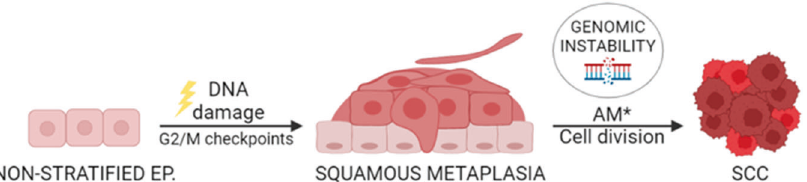
Fig. 7 Model for the role of DNA-damage and mitotic checkpoints in the development of squamous metaplasia and subsequent squamous cancer in non-strati fi ed epithelia. Chronic or acute exposure of non-squamous epithelia to genotoxic agents would drive G2/M arrest via the DNA damage response. In turn, G2/M checkpoints would drive benign hyperplastic squamous differentiation (squamous metaplasia). Unrepaired cells would undergo terminal post-mitotic squamous differentiation. In the event of additional mutations (AM) hitting the G2/M checkpoints, cells overcoming the cell division block would proliferate bearing genomic instability, eventually resulting in cancer. Ep: epithelium. Created with